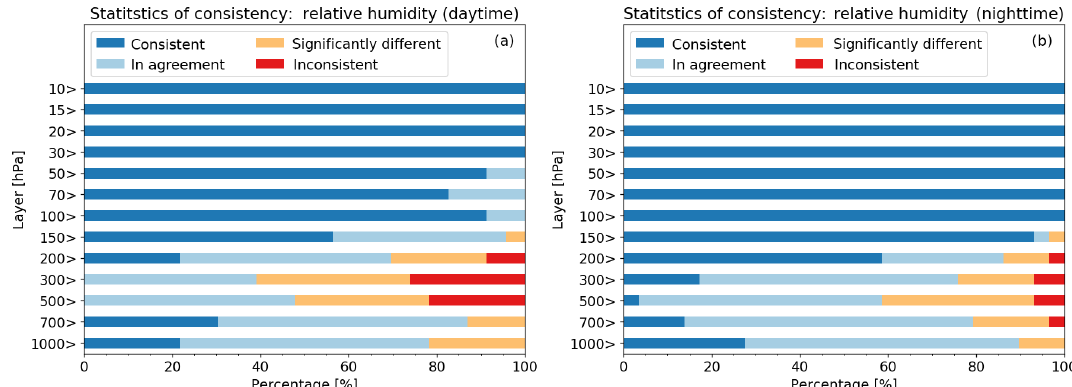
Figure 27. As per Fig. 24, but for RH. RH results for the stratosphere are not discussed here because measurement values for the stratosphere are considered to exceed the limit for reliable